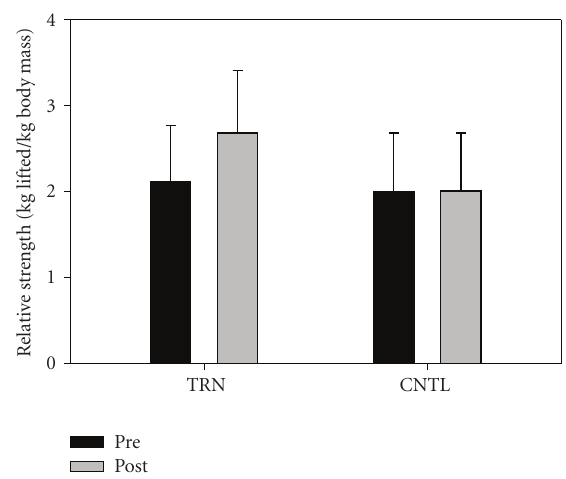
Figure 1: Leg Press 1-RM adjusted for body mass (kg/kg) for TRN (Pre = 4.7 ± 1.4, Post 5.9 ± 1.6) and CNTL (Pre = 4.4 ± 1.5, Post 4.4 ± 1.4). A significant interaction e ff ect was noted ( P = . 001). Post hoc analysis indicates a significant increase over time for TRN ( P = . 001).